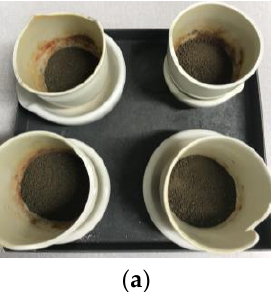
Figure 6 . Appearance of the ash fractions collected from combustion in the bomb calorimeter: ( a ) Lidköping sludge ashes and ( b ) Borås sludge ash.